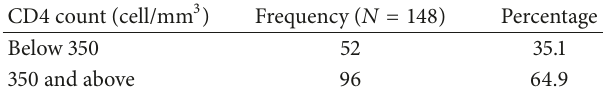
Table 6: Participants most recent CD4 count results after taking antiretroviral medication for at least 6